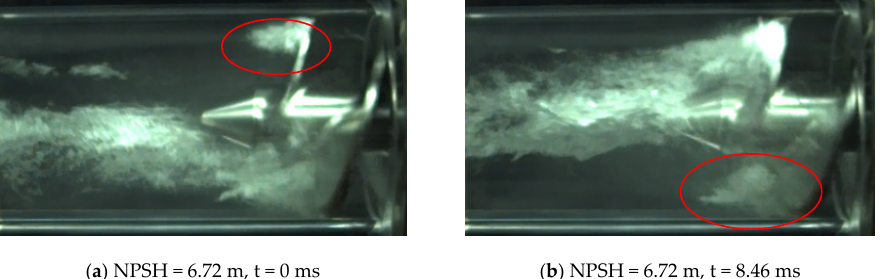
Figure 11. Vortex distribution at different times (Q = 0.14 Q d and NPSH = 10 m).